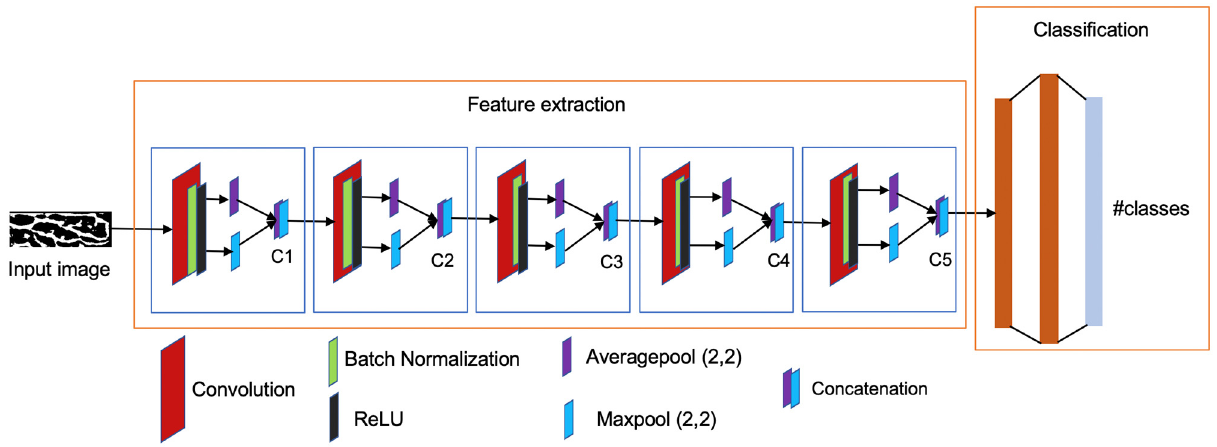
Figure 2. The proposed FVR-Net